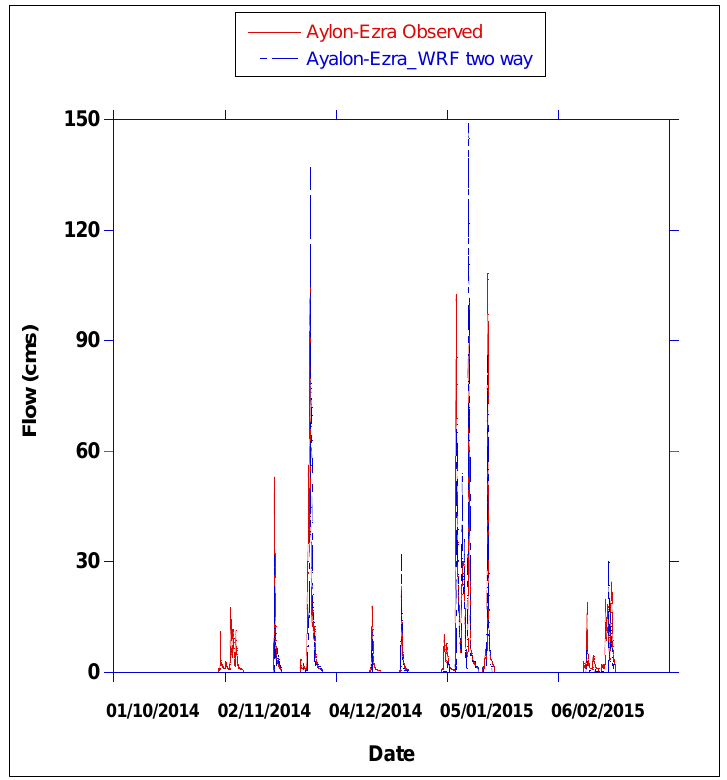
Figure 11. Observed flow at Ayalon–Ezra hydrometric station ( red ) vs. two way WRF-Hydro simulated for the full 2014/15 rainy season (October 2014–March 2015).